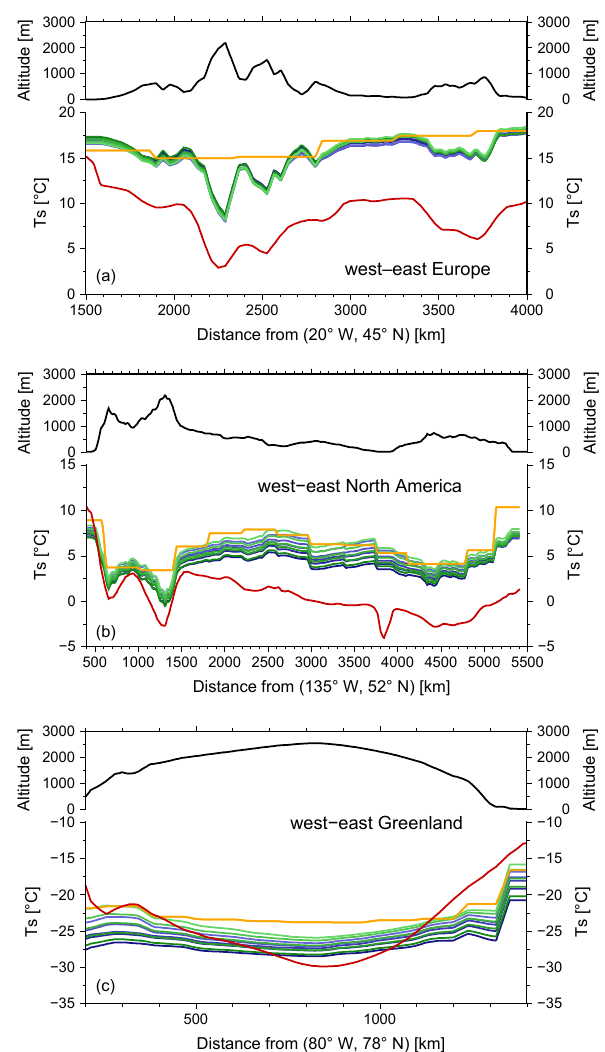
Figure 4. Transects for selected regions: Europe (a) , North America (b) and Greenland (c) . The upper part of each panel shows the eleva- tion along the transects. The lower part of each panel depicts the an- nual mean surface temperature along the transects for: ERA-Interim (red), the standard i LOVECLIM (CTRL, orange), the i LOVECLIM including a downscaling with f s = 1 . 0 (blue), the i LOVECLIM in- cluding a downscaling with f s = 0 . 6 (green). The different shades of blue and green correspond to α min q ranging from 0.7 (dark) to 0.9 (light). The downscaling experiments presented in this figure use z q = 2000m and a change to z q = 3500m has only a very limited